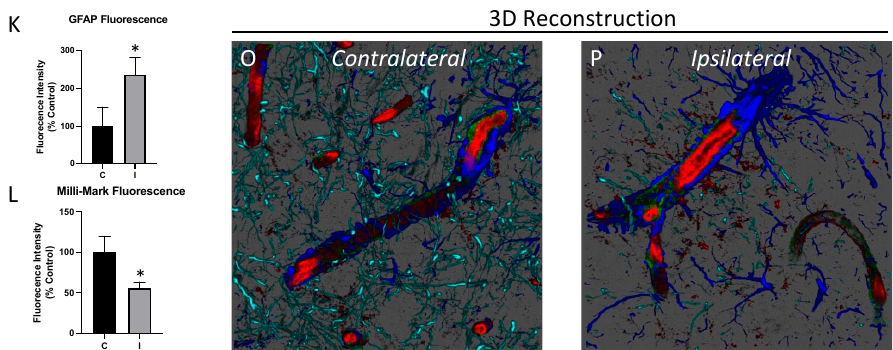
Figure 5. Ischemia-reperfusion injury induces changes in the NVU. The NVU was stained with lectin ( A , B ), anti-PDGFR- β ( C , D ), anti-GFAP ( E , F ) and the Pan Neuronal antibody ( G , H ), and cortical microvessels in the hemisphere ipsilateral to where an MCAO was performed were compared to the contralateral hemisphere. The ipsilateral hemisphere shows an increased association of microglia with capillaries (arrows in B ), an increased in GFAP fluorescence (arrows in F ), and neurite loss (arrows in H ) when compared to the contralateral side. Representative images of TTC-stained coronal sections from control ( I ) and MCAO treated rats ( J ) with boxes showing the approximate regions where the ipsilateral ( I ) and contralateral ( C ) images were acquired. Fluorescence intensity from the contralateral ( C ) and ipsilateral ( I ) regions was quantified for GFAP ( K ) and Milli-Mark ( L ) staining ( n = 6). Merged images ( M , N ) and 3D reconstructions ( O , P ) are shown below. Images are representative of randomly chosen regions of interest in the somatosensory cortex from 6 different rats. Scale bar = 10 μ m; * p < 0.05.